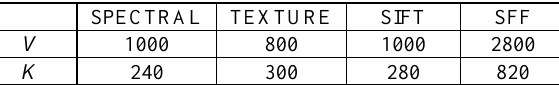
Table 3. Optimal V and K values for the different feature strategies with the Google dataset of SIRI-WHU